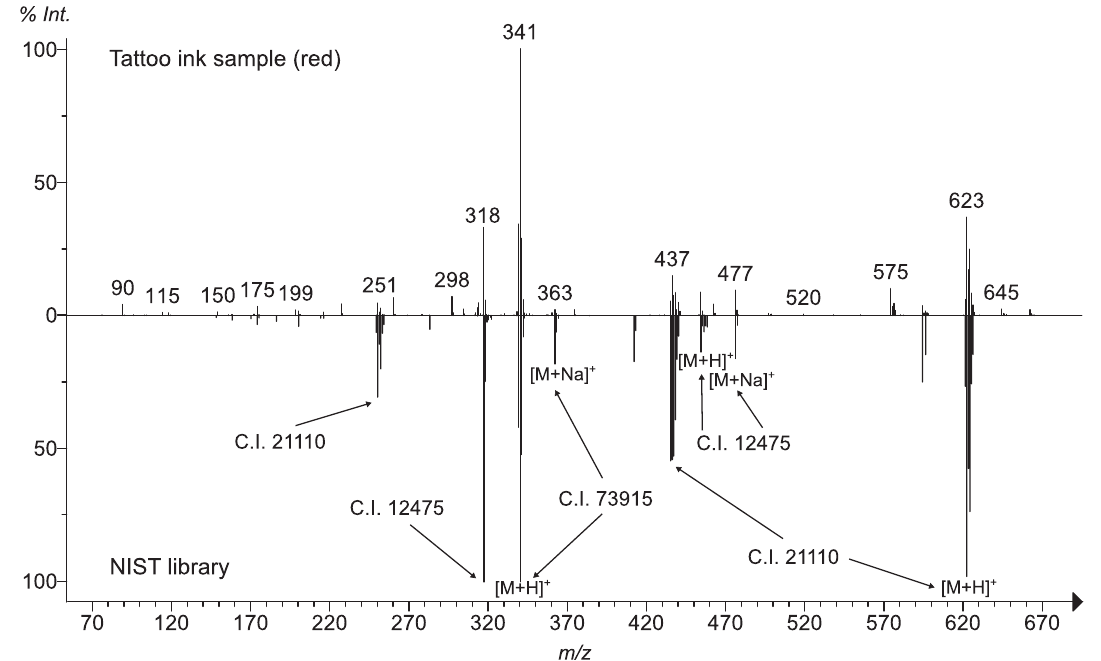
Figure 2. Head to tail plot of three pigments identified in the mass spectra of a red tattoo ink sample by NIST software: C.I.73915 (Pigment Red 122, R. Match = 878), C.I.21110 (Pigment Orange 13, R. Match = 833) and C.I.12475 (Pigment Red 170, R. Match =